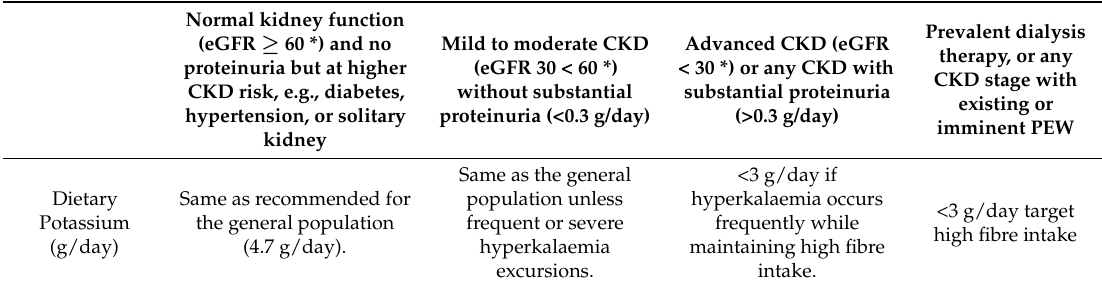
Table 1. Recommended dietary potassium intake at different Stages of chronic kidney disease in adults. Adapted from Table 2 in Kalantar-Zadeh K and Fouque D